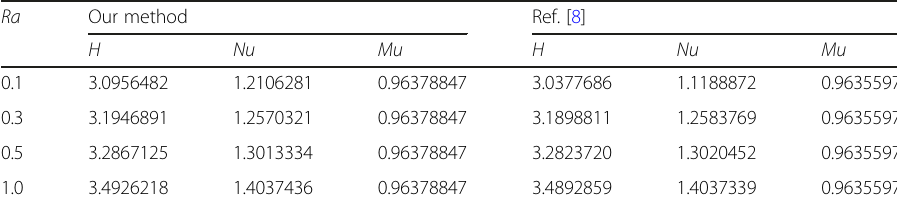
Table 8 Comparison of our method and Makinde [8] using different values of Ra and step size Δη